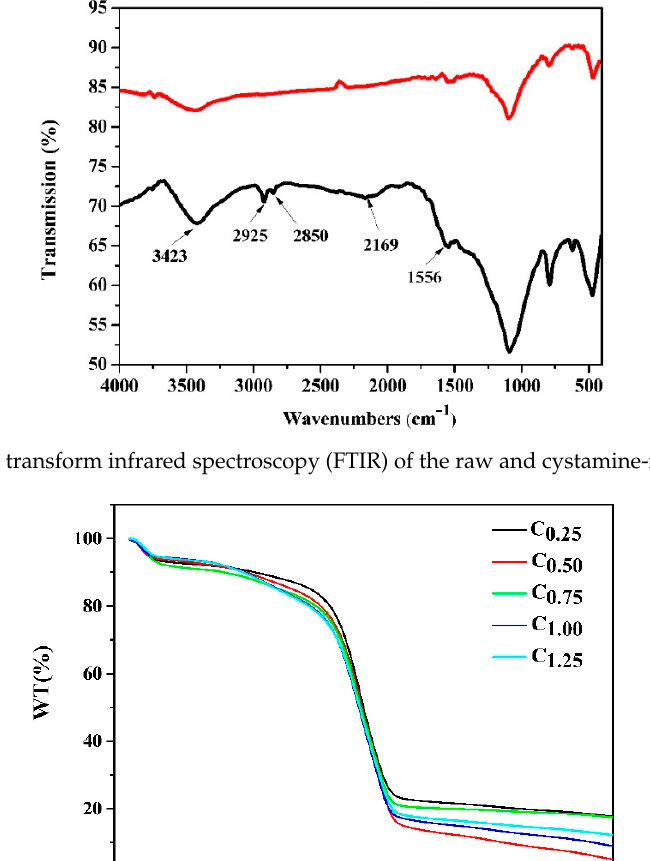
Figure 2. Fourier transform infrared spectroscopy (FTIR) of the raw and cystamine-modified biochars.